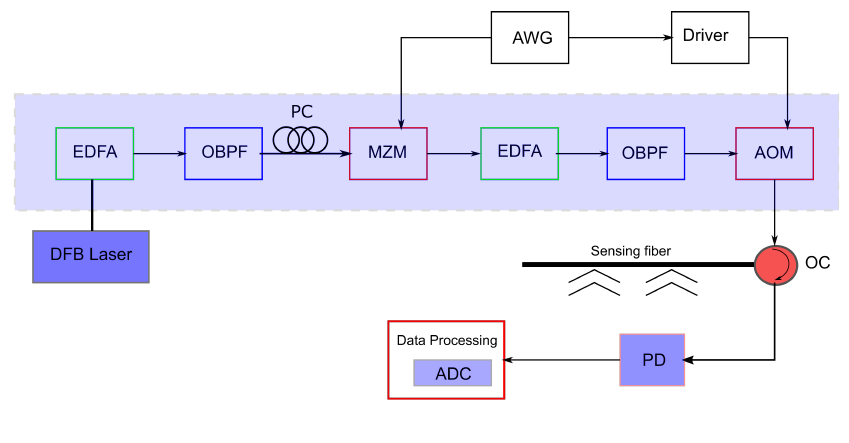
Figure 8. Experimental setup of a pulse-coded standard φ -OTDR system. DFB: Distributed Feedback, AOM: Acousto-Optic Modulator, EDFA: Erbium-Doped Fiber Amplifier, MZM: